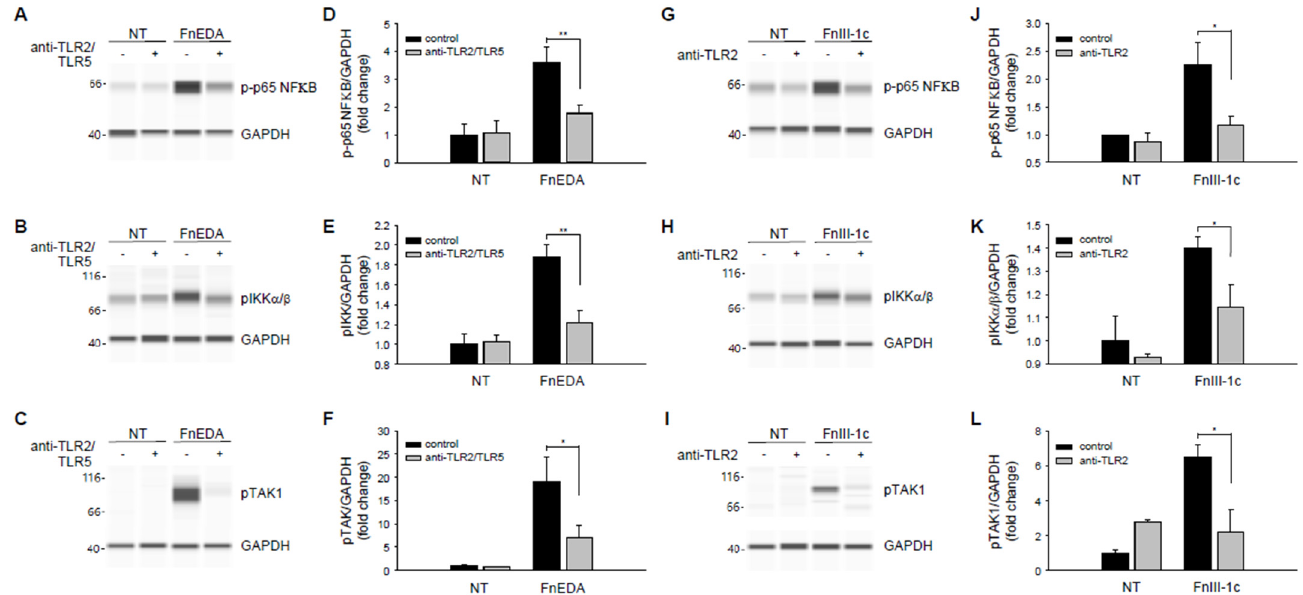
Figure 6. Effect of neutralizing antibodies to TLR2 and TLR5 on FnEDA- and FnIII-1c-induced NF κ B signaling in MDA-MB-231 breast cancer cells. MDA-MB-231 breast cancer cells were incubated for 1 h with a TLR2 neutralizing antibody (2 µg/mL; anti-TLR2) alone or in combination with a TLR5 neutralizing antibody (2 µg/mL; anti-TLR2/TLR5) prior to treatment with either ( A – F ) FnEDA (5 µM) or ( G – L ) FnIII-1c (10 µM) for 1 h. Whole-cell lysates were collected and analyzed by WES. Representative Wes-ProteinSimple assay for ( A , G ) phospho-p65 NF κ B, ( B , H ) phospho-IKK α / β , and ( C , I ) phospho-TAK1 are shown. Western analyses shown in ( A – C , G – I ) were quantified and normalized to GAPDH expression ( D – L , respectively). Data represent the mean ± SEM of three independent determinations. NT indicates no treatment. * p < 0.05; ** p < 0.01; Student’s t-test.